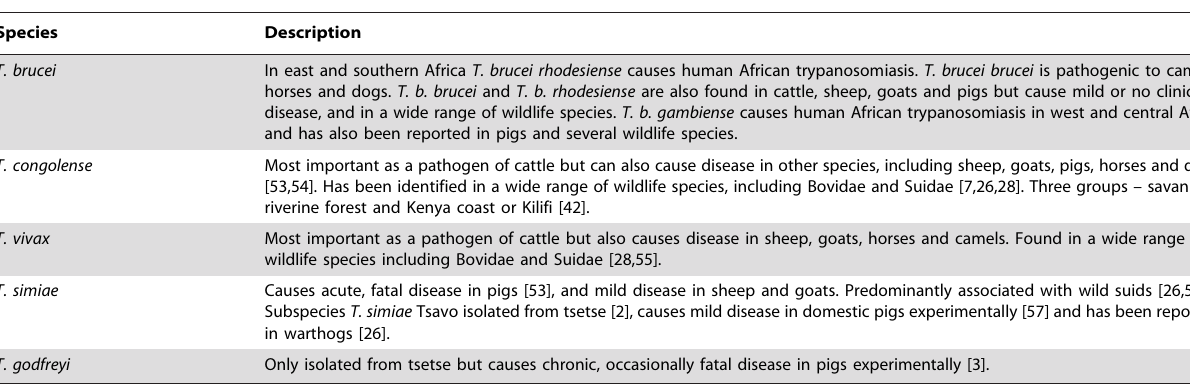
Table 1. Summary of the host range and pathogenicity of the Salivarian